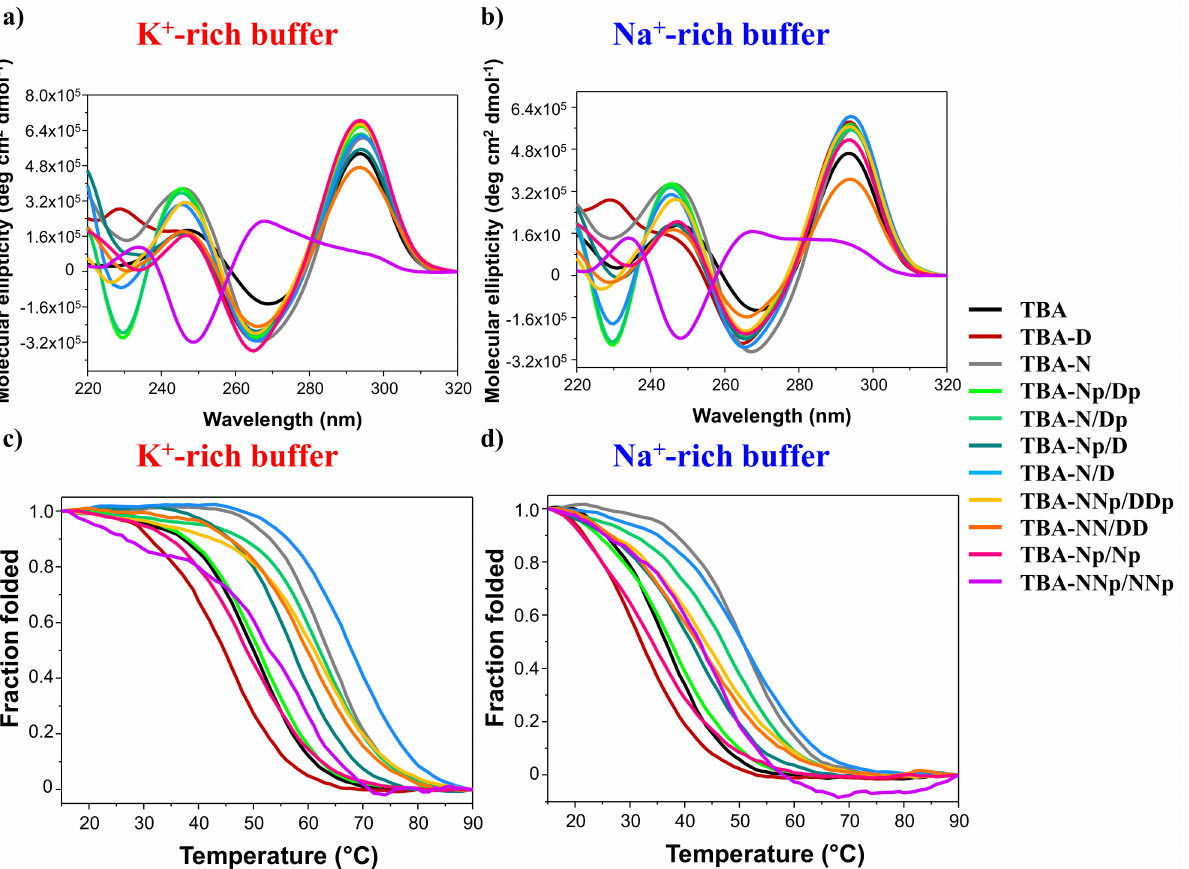
Figure 4. Representative overlapping CD spectra ( a , b ) and CD-melting profiles ( c , d ) of the TBA analogues investigated in comparison with unmodified TBA (black line). CD spectra were recorded at 2 µ M and 15 ◦ C in both the K + -rich ( a ) and Na + - rich ( b ) buffer solutions. CD-melting profiles—at 2 µ M in the 15–90 ◦ C range using a scan rate of 1 ◦ C/min—were recorded in both the K + -rich ( c ) and Na + -rich ( d ) buffer solutions at the maximum ellipticity observed for each oligonucleotide system and are reported as folded fractions of each oligonucleotide system as a function of